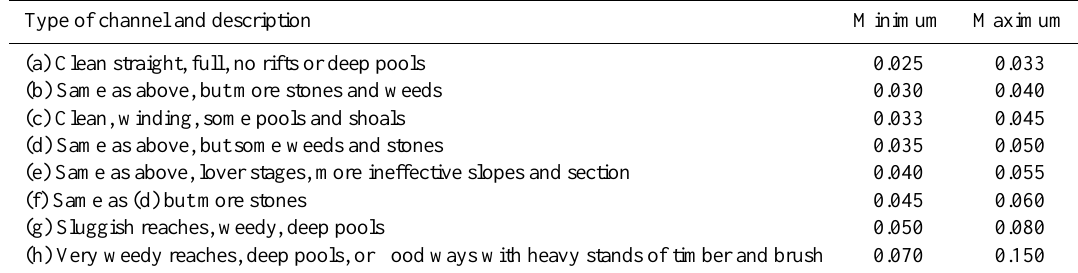
Table 2. Manning’s roughness coefficients for main channels in natural streams (Chow, 1959). Type of channel and